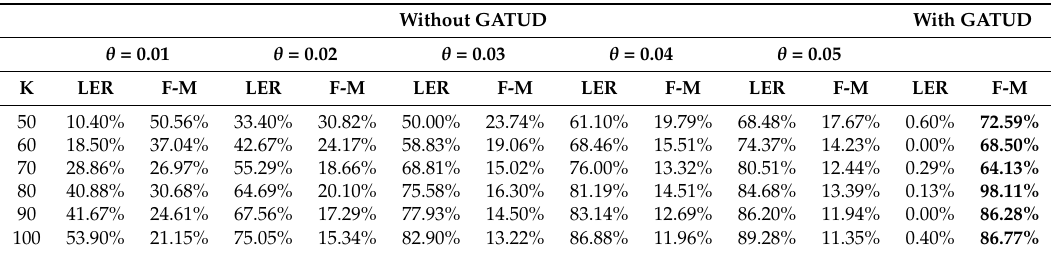
Table 18. The detection accuracy of k -means clustering algorithm with/without GATUD on SimData1. Without GATUD With GATUD θ = 0.01 θ = 0.02 θ = 0.03 θ = 0.04 θ = 0.05